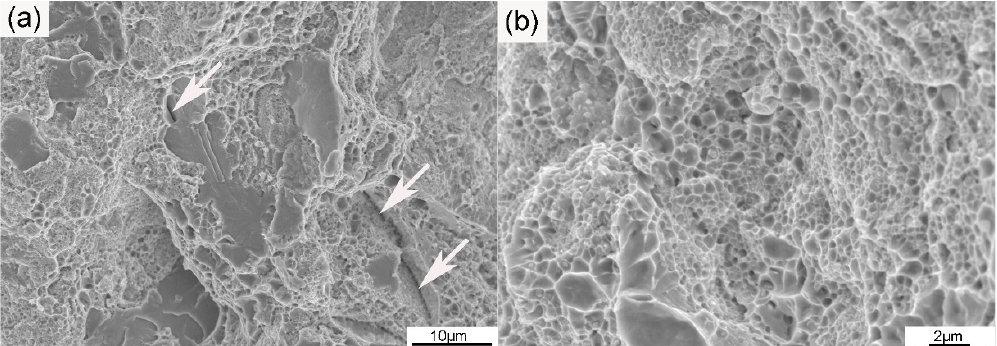
Figure 8. SEM images of ( a ) the typical fracture surface at low magnification and ( b ) the dimple fracture region at high magnification of the ODS sample. Arrows in (a) show the distribution of cracks.